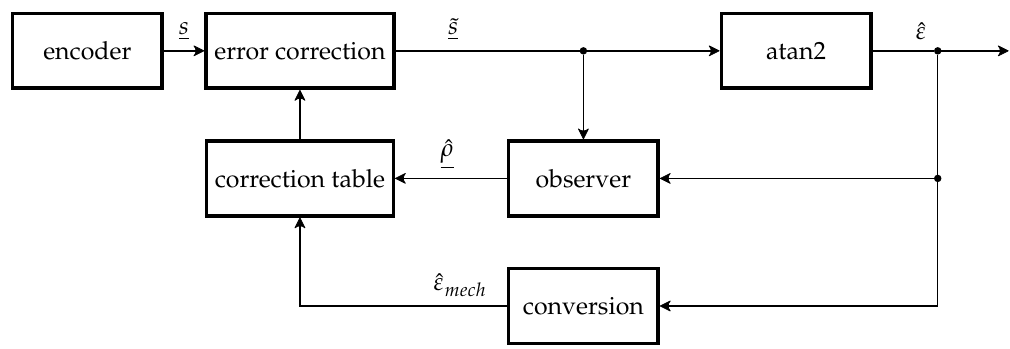
Figure 7. Scheme of the proposed Iterative Harmonic Error Correction